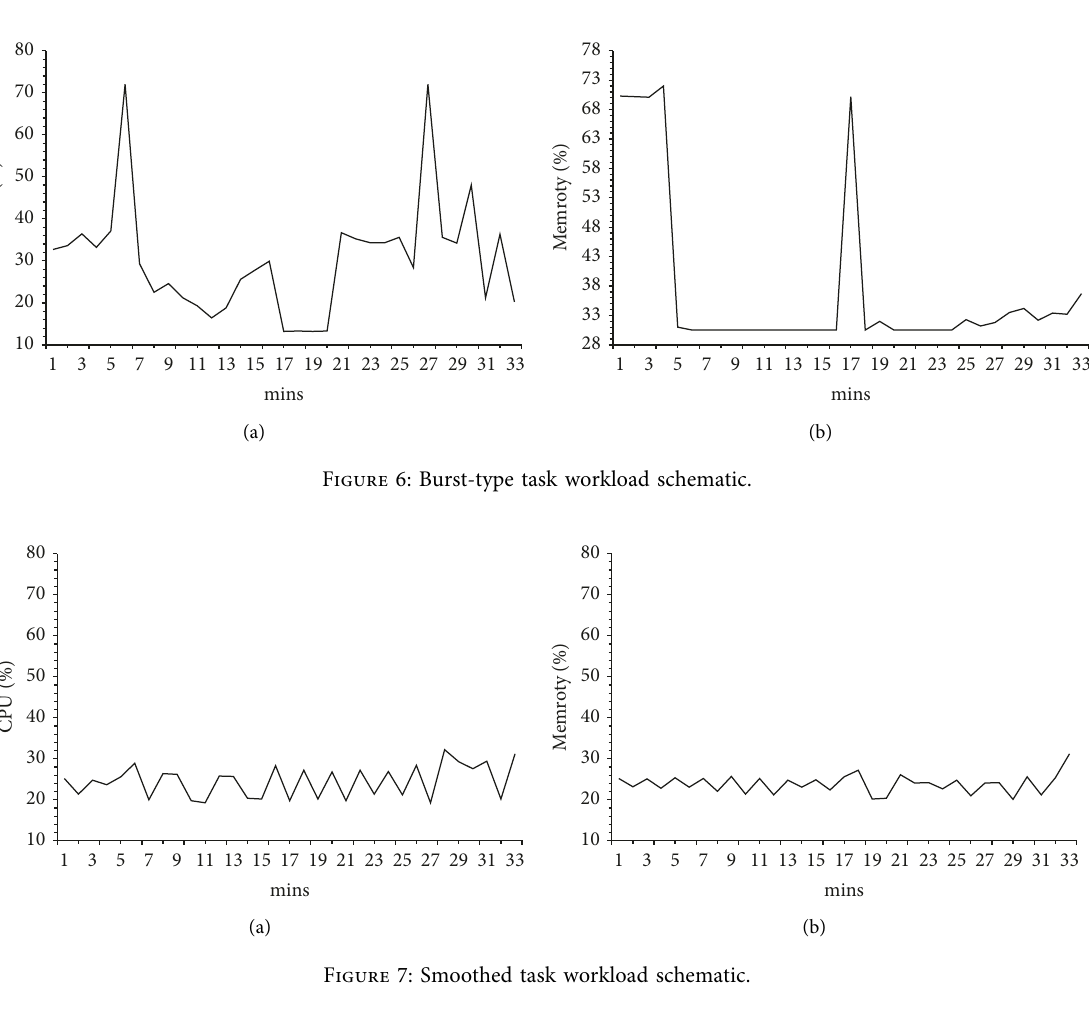
Figure 7: Smoothed task workload schematic.